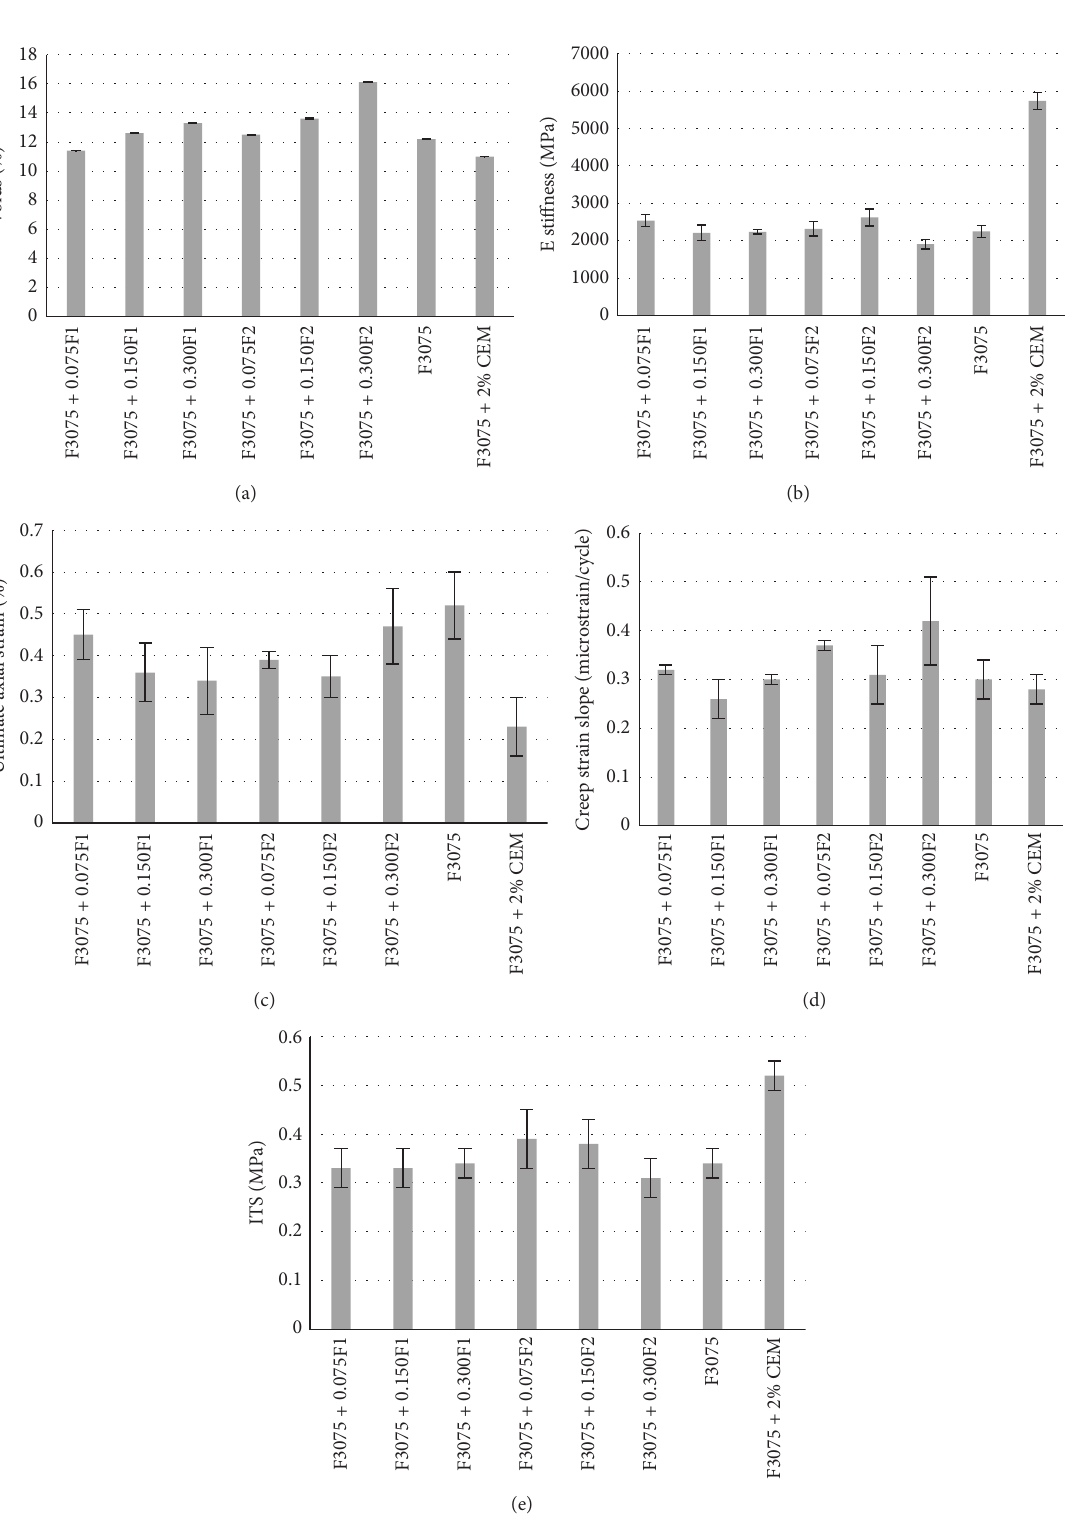
Figure 5: Effect of fiber types on (a) voids, (b) stiffness, (c) UAS, (d) CSS, and (e) ITS. E: Stiffness